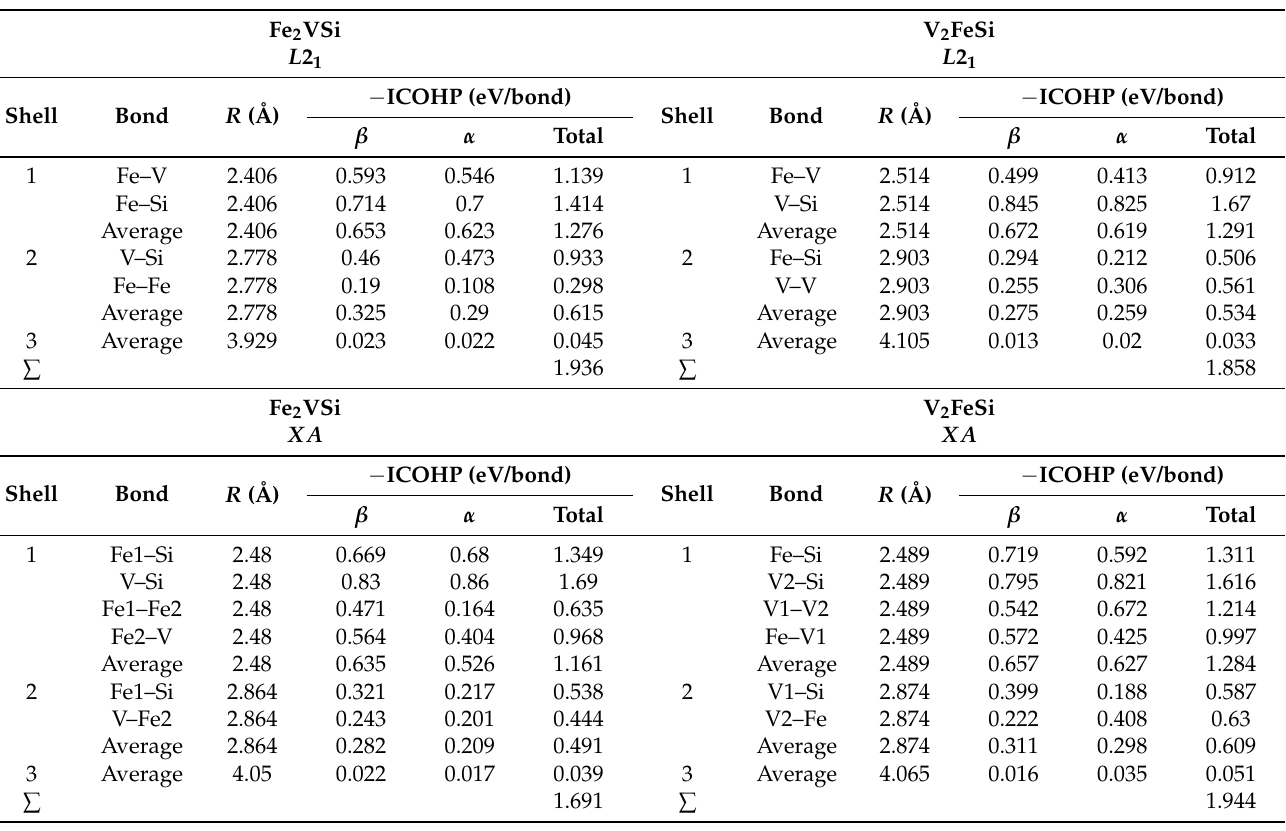
Table 3. Calculated − ICOHP values for all types of atomic pairs in the first and second coordination spheres. The average values of all interatomic interactions are given for the third coordination sphere. R stands for interatomic distances. The data are given for different spin projections— α and β states. The total corresponds to the sum of α and β values of − ICOHP, while ∑ means the sum of average − ICOHP values for all three coordination